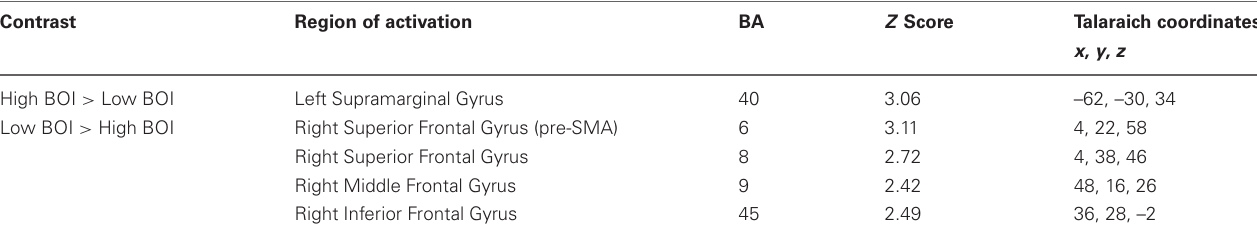
Table 2 | Areas of significant activation in contrasts between word